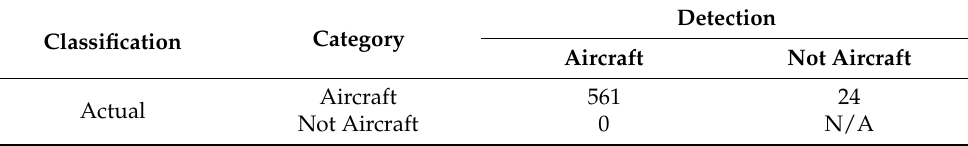
Table 2. Confusion matrix of faster RCNN.